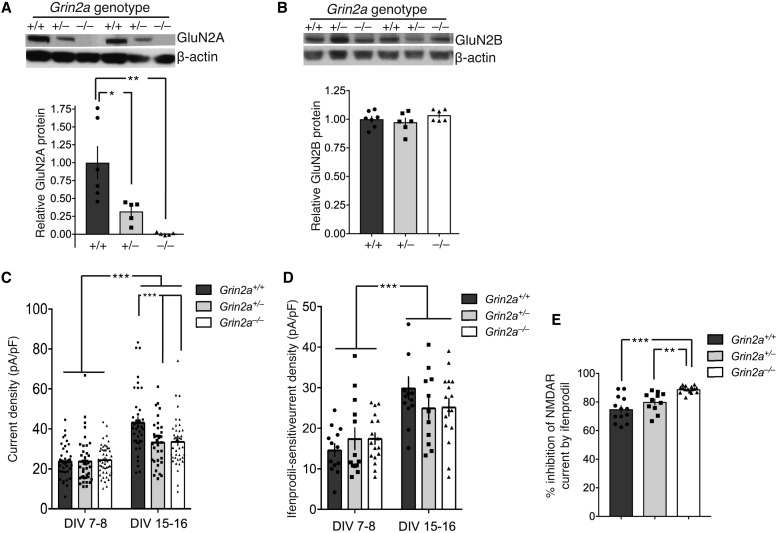

No compensation by GluN2B. GluN2B-mediated currents do not increase to compensate for GluN2A deficiency in cortical neurons from a Grin2a knock-out rat. (A) Western blot and quantification confirming the absence of GluN2A expression in Grin2a−/− neurons, and an intermediate expression level in Grin2a+/− neurons at 15 DIV. Tukey’s test reveals a significant difference between Grin2a+/+ versus Grin2a+/− (P = 0.0196) and versus Grin2a−/− (P = 0.0014). Grin2a+/+: n = 6; Grin2a+/−: n = 5; Grin2a−/−: n = 5. (B) Western blot and quantification confirming no changes in GluN2B expression in either Grin2a+/− or Grin2−/− neurons compared to Grin2a+/+ neurons at 15 DIV. Grin2a+/+, n = 6; Grin2a+/−: n = 5; Grin2a−/−: n = 5. (C) NMDA (150 µM) evoked currents were measured in cortical neurons of the indicated genotypes and periods of culture. Currents were calculated and normalized to cell capacitance to give a value for the current density within the neuron. Two-way ANOVA reports a significant developmental stage effect (P < 0.0001) and a significant genotype effect (P = 0.013) as well as a significant interaction between the two (P = 0.0059). Sidak’s post hoc test reveals a significant difference between Grin2a+/+ versus Grin2a+/− (P = 0.0007) and versus Grin2a−/− (P = 0.0006). Grin2a+/+: n = 38 (7–8 DIV), 38 (15–16 DIV) cells, eight animals; Grin2a+/−: n = 40 (7–8 DIV), 35 (15–16 DIV) cells, nine animals; Grin2a−/−: n = 48 (7–8 DIV), 31 (15–16 DIV) cells, 10 animals. (D) NMDA (150 µM) evoked currents were measured in cortical neurons of the indicated genotypes and periods of culture before and after the application of the GluN2B-selective antagonist ifenprodil (3 µM). The ifenprodil-sensitive current was calculated and normalized to cell capacitance. Two-way ANOVA reports a significant developmental stage effect (P < 0.0001) but no significant genotype effect (P = 0.880) nor a significant interaction between the two (P = 0.154). Grin2a+/+: n = 13 (7–8 DIV), 13 (15–16 DIV) cells, four animals; Grin2a+/−: n = 13 (7–8 DIV), 11 (15–16 DIV) cells, five animals; Grin2a−/−: n = 17 (7–8 DIV), 16 (15–16 DIV) cells, five animals. (E) At 15–16 DIV the percentage inhibition of NMDA (150 µM) evoked currents by ifenprodil (3 µM) was significantly greater (Tukey’s test) in Grin2a−/− neurons compared to Grin2a+/+ neurons (P < 0.0001) and Grin2a+/− neurons (P = 0.0038). DIV = day in vitro.